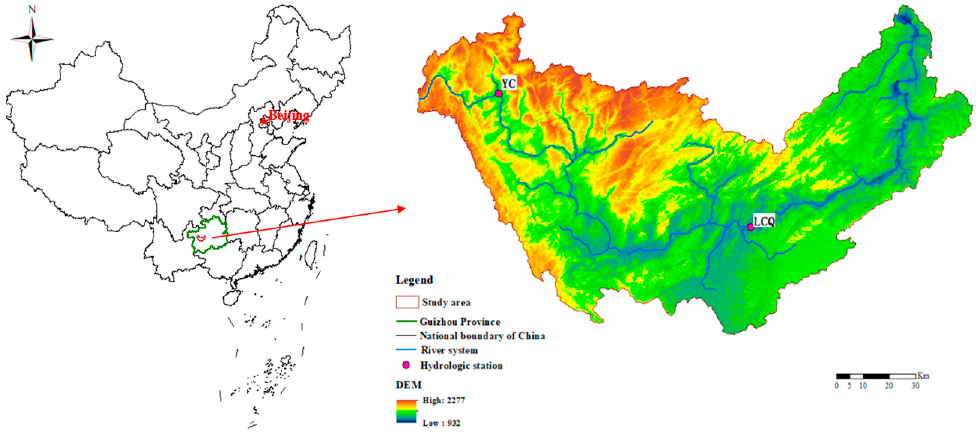
Figure 1. Map of the basic environmental elements of the study area in northwestern Guizhou Province, China.